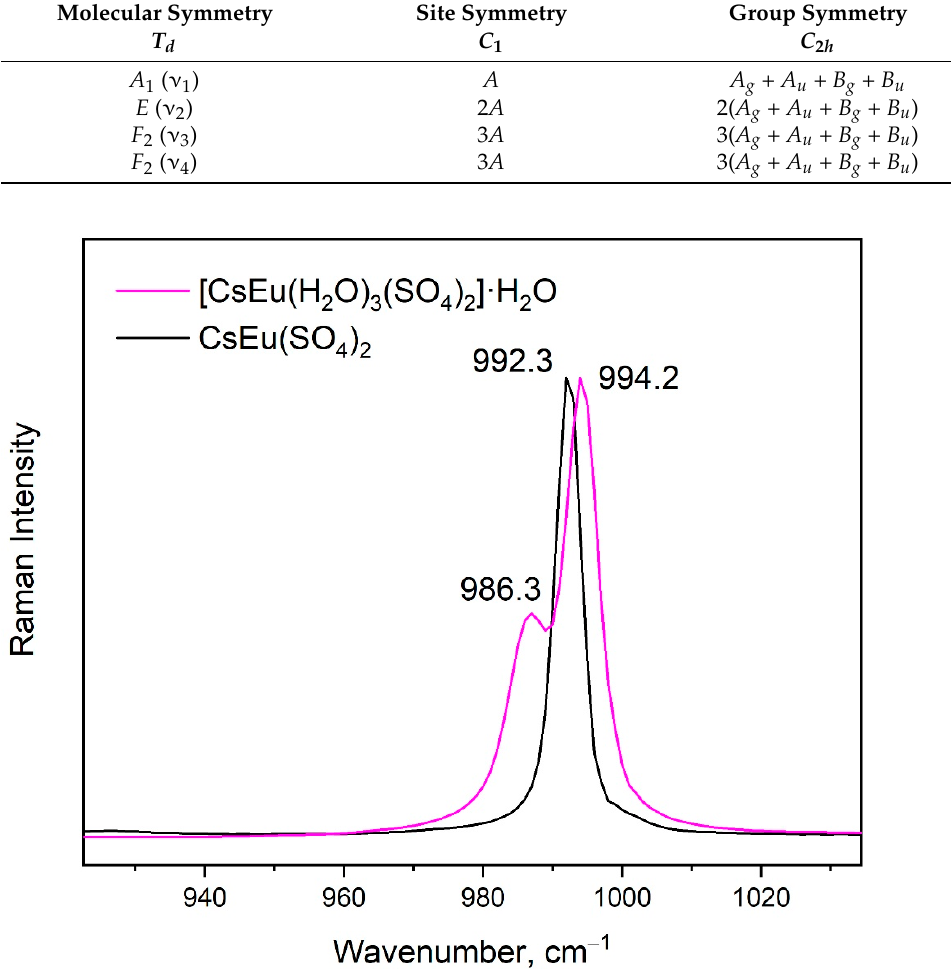
Figure 6. Comparison of the Raman spectra of [CsEu(H 2 O) 3 (SO 4 ) 2 ]·H 2 O (purple curve) and CsEu(SO 4 ) 2 (black curve) in the range of sulfate tetrahedra stretching.